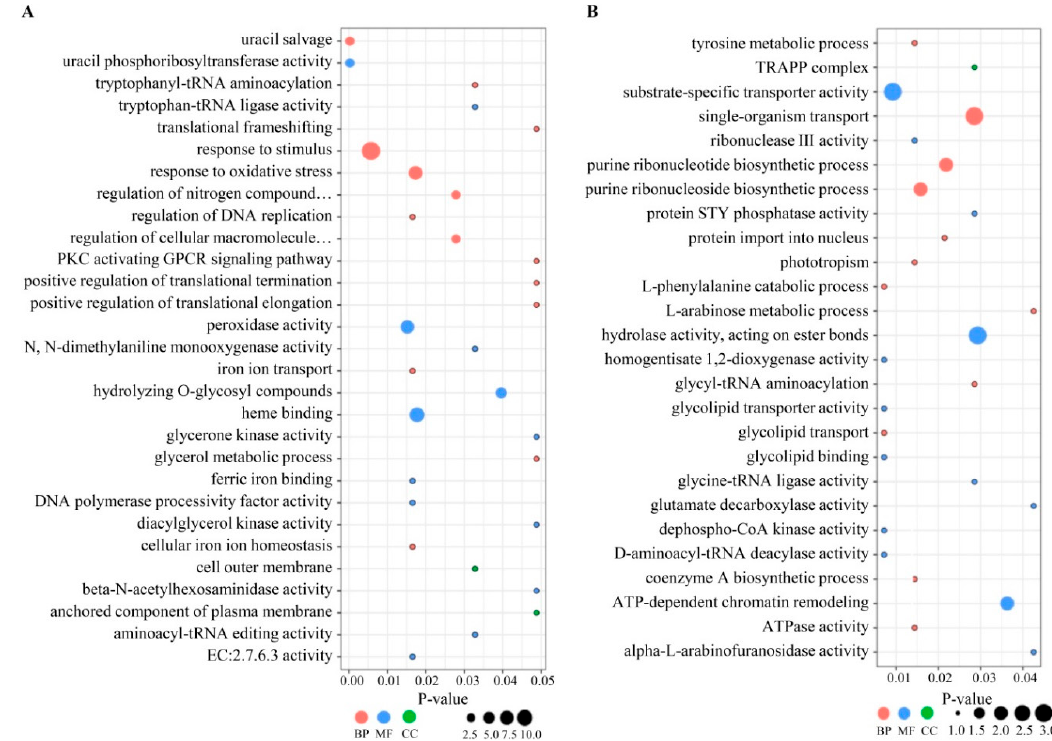
Figure 2. Gene ontology (GO) classification of significantly upregulated ( A ) and downregulated ( B ) differentially expressed proteins (DEPs) in sugarcane cultivar LCP 85–384 inoculated with Xanthomonas albilineans (R48_Xa vs. R0_CK). LCP 85–384 is resistant to leaf scald. DEPs were annotated with a GO term belonging to one of three biological process categories: biological process (BP, in pink color), molecular function (MF, in blue color), and cellular component (CC, in green color). The X-axis represents the p -value and Y-axis shows the GO term